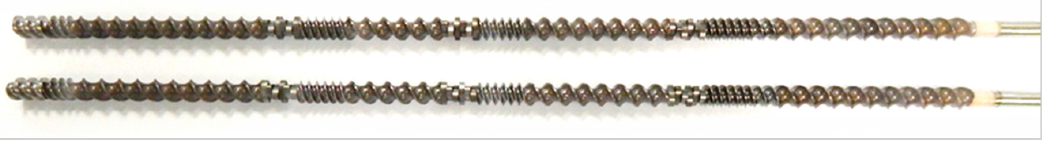
Figure 2. Screw configuration for Thermo Fisher Scientific ® Pharma 11-mm extrusion. Table 4. Hot-melt extrusion (HME) process